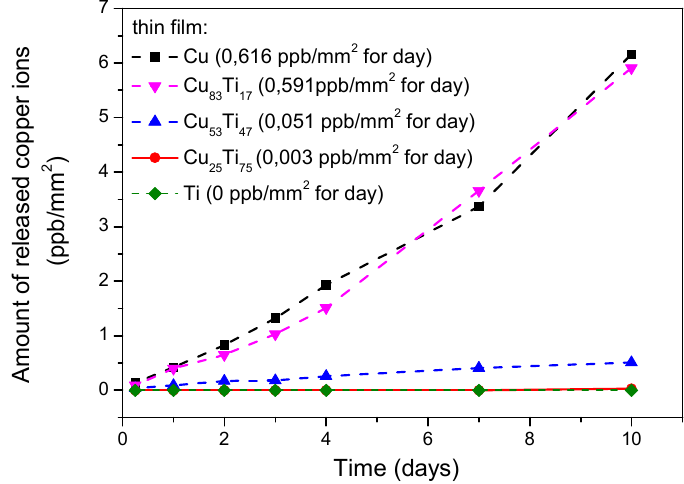
Figure 10. The amount of copper ions released into the environment from the surface of nanocrystalline thin films based on Cu and Ti determined by the AAS method.